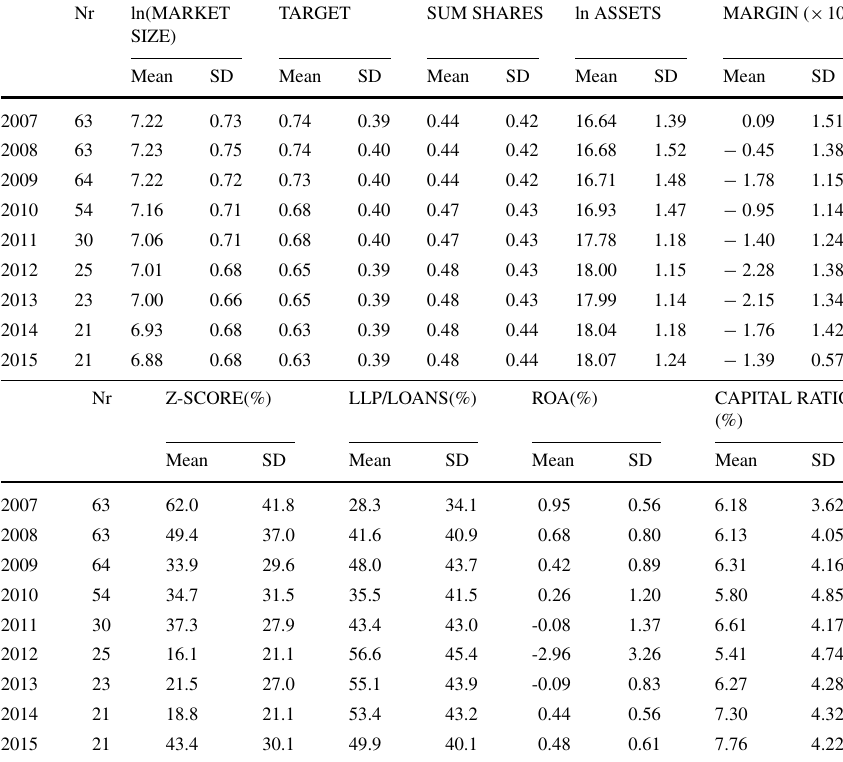
Table 2 Descriptive statistics; Spanish banks,